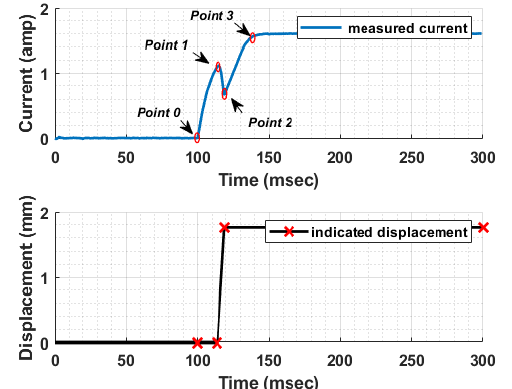
Figure 18 Comparison between identified and measured displacement when the solenoid is